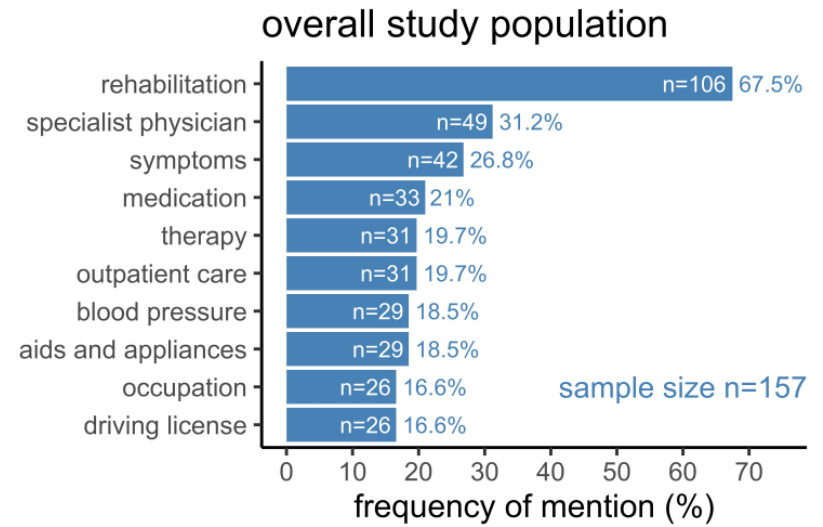
Figure 1. Topics mentioned during a stroke pilot-based phone call two months after hospital discharge. Bars represent the number of patients (n) who mentioned a specific topic. Added rates represent the percentage of patients (%) with respect to the underlying sample size.